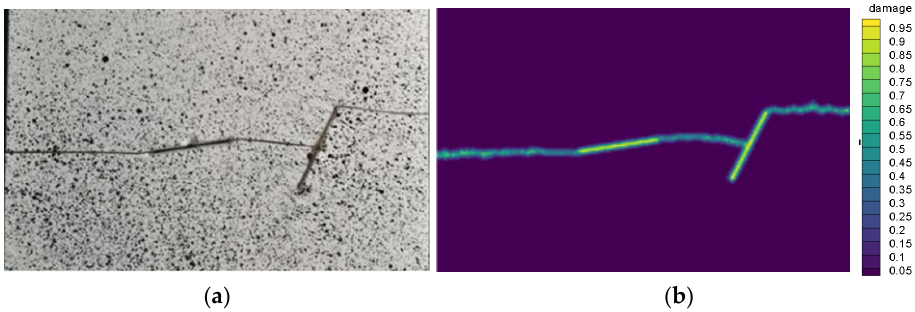
Figure 4. Crack path at complete failure obtained from the ( a ) experiment [16] and ( b ) numerical simulation.